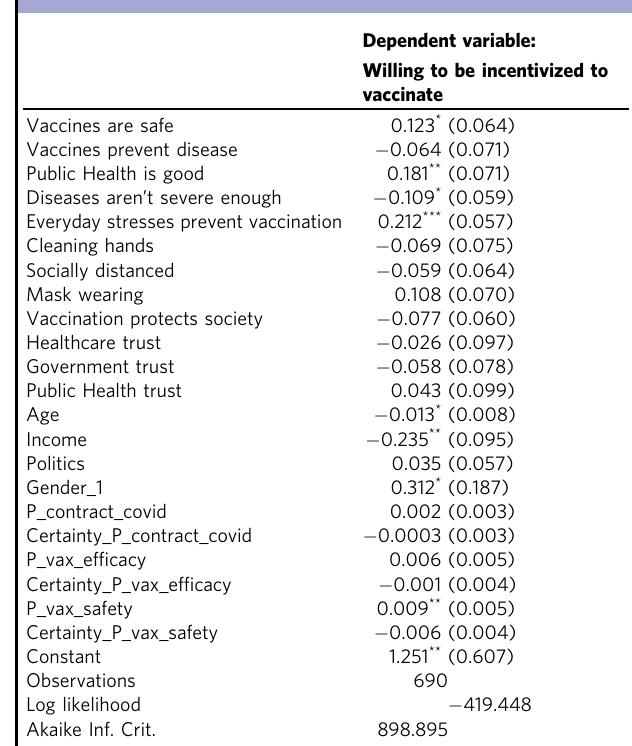
Table 6 Classi fi cation model of hesitants into reluctants and